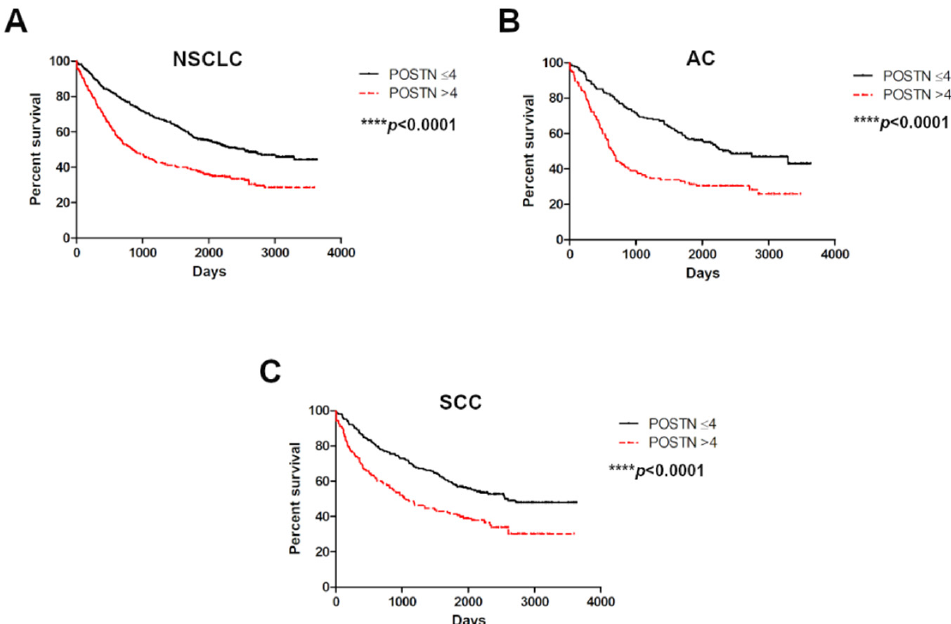
Figure 6. Kaplan–Meier overall survival curves in regard to cytoplasmic POSTN expression in ( A ) non-small cell lung carcinoma (NSCLC), ( N = 715) and non-small cell lung carcinoma (NSCLC) subtypes: ( B ) adenocarcinoma (AC), ( N = 298) and ( C ) squamous cell carcinoma (SCC), ( N = 370). Analysis using the Mantel–Cox test. **** p < 0.0001. Cut-off points for the analysis were estimated based on the median.